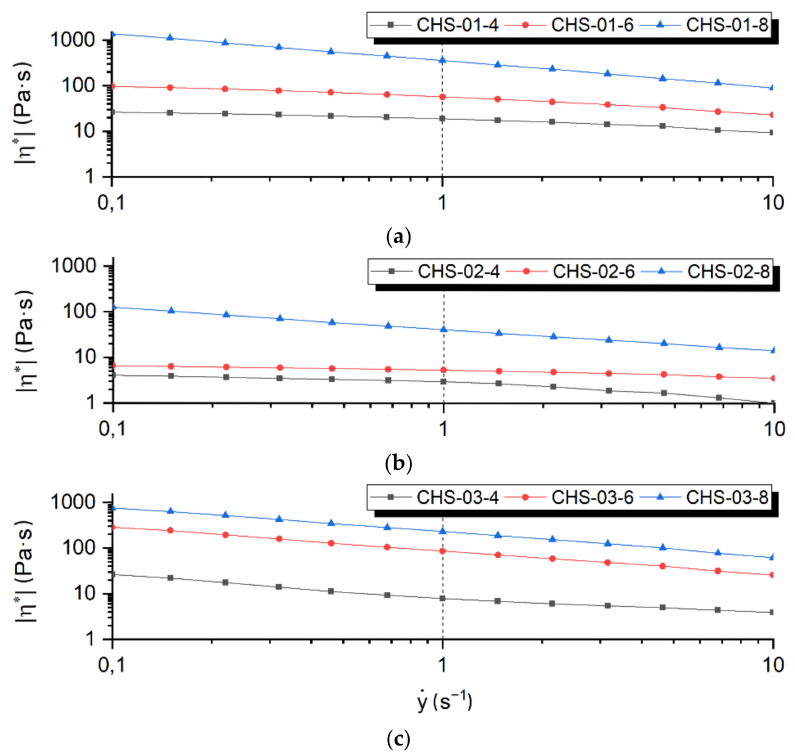
Figure 2. Viscosity of spinning dopes with solids contents of 4 wt.%, 6 wt.%, and 8 wt.% prepared from ionic liquid BmimOAc and chitosan CHS-01 ( a ), CHS-02 ( b ), and CHS-03 ( c